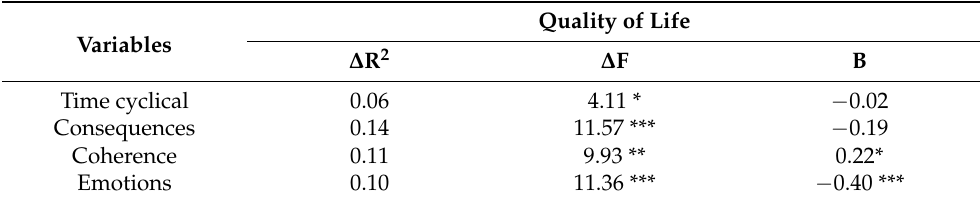
Table 3. The hierarchical regression analysis for the illness perception dimensions predicting total quality of life.